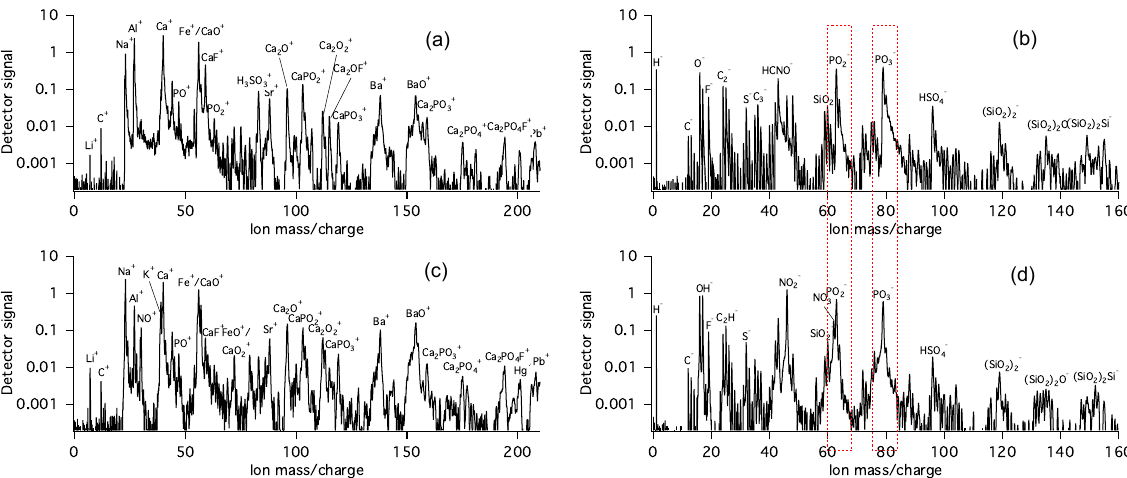
Figure 3. Representative PALMS spectra of coal fly ash from the J. Robert Welsh power plant. (a, b) Unprocessed fly ash. (c, d) Fly ash processed with HNO 3 (see text for details). Right and left columns are positive and negative polarity, respectively. Red dotted lines are features indicated in the literature as markers for biological